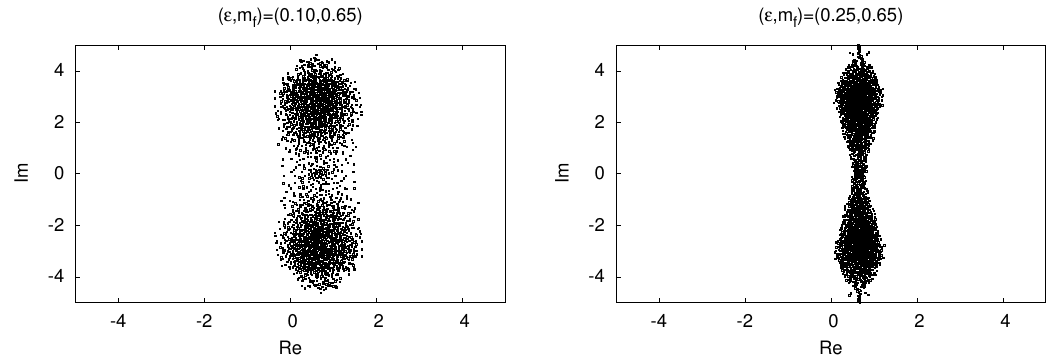
Figure 2 . The scatter plot of the eigenvalues of the 4( N 2 (cid:0) 1) (cid:2) 4( N 2 (cid:0) 1) matrix f M obtained with a thermalized con(cid:12)guration for N = 24 and m f = 0 : 65 with " = 0 : 1 (Left) and " = 0 : 25